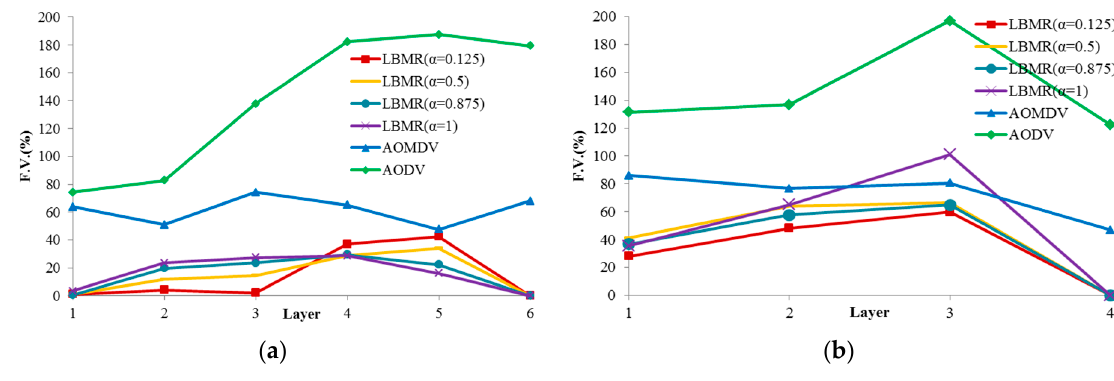
Figure 5. Flow variance of each layer. ( a ) Grid topology; ( b ) Random topology.